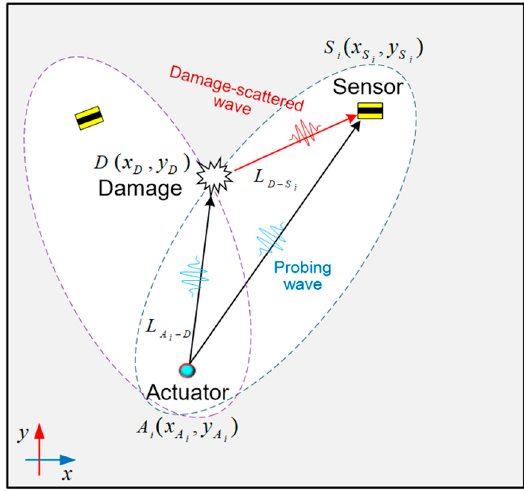
Figure 10. Relative position of the actuator A i , sensor S i , and damage D for a sensing path.